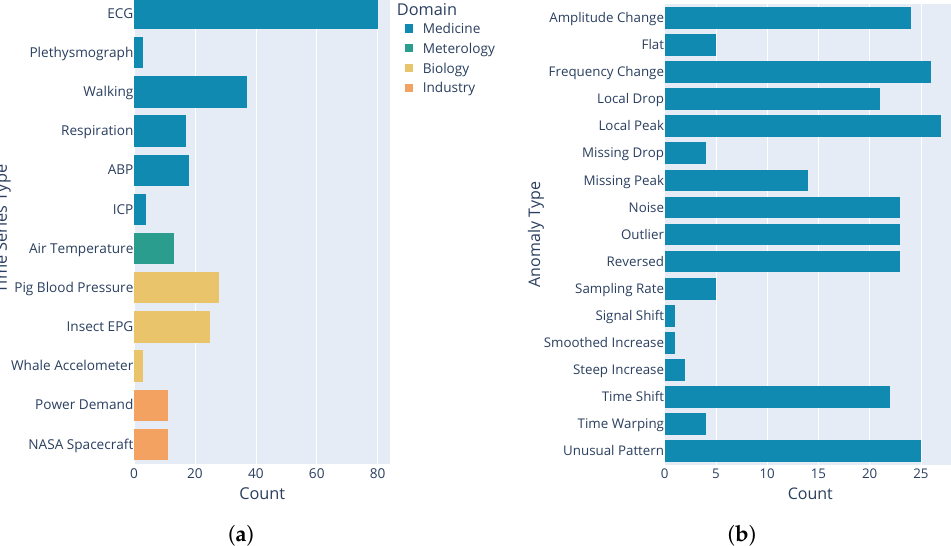
Figure 2. ( a ) Histogram of time series types included in the UCR Anomaly Archive. The color indicates the domain the time series originates from. ( b ) Histogram of anomaly types present in the UCR Anomaly